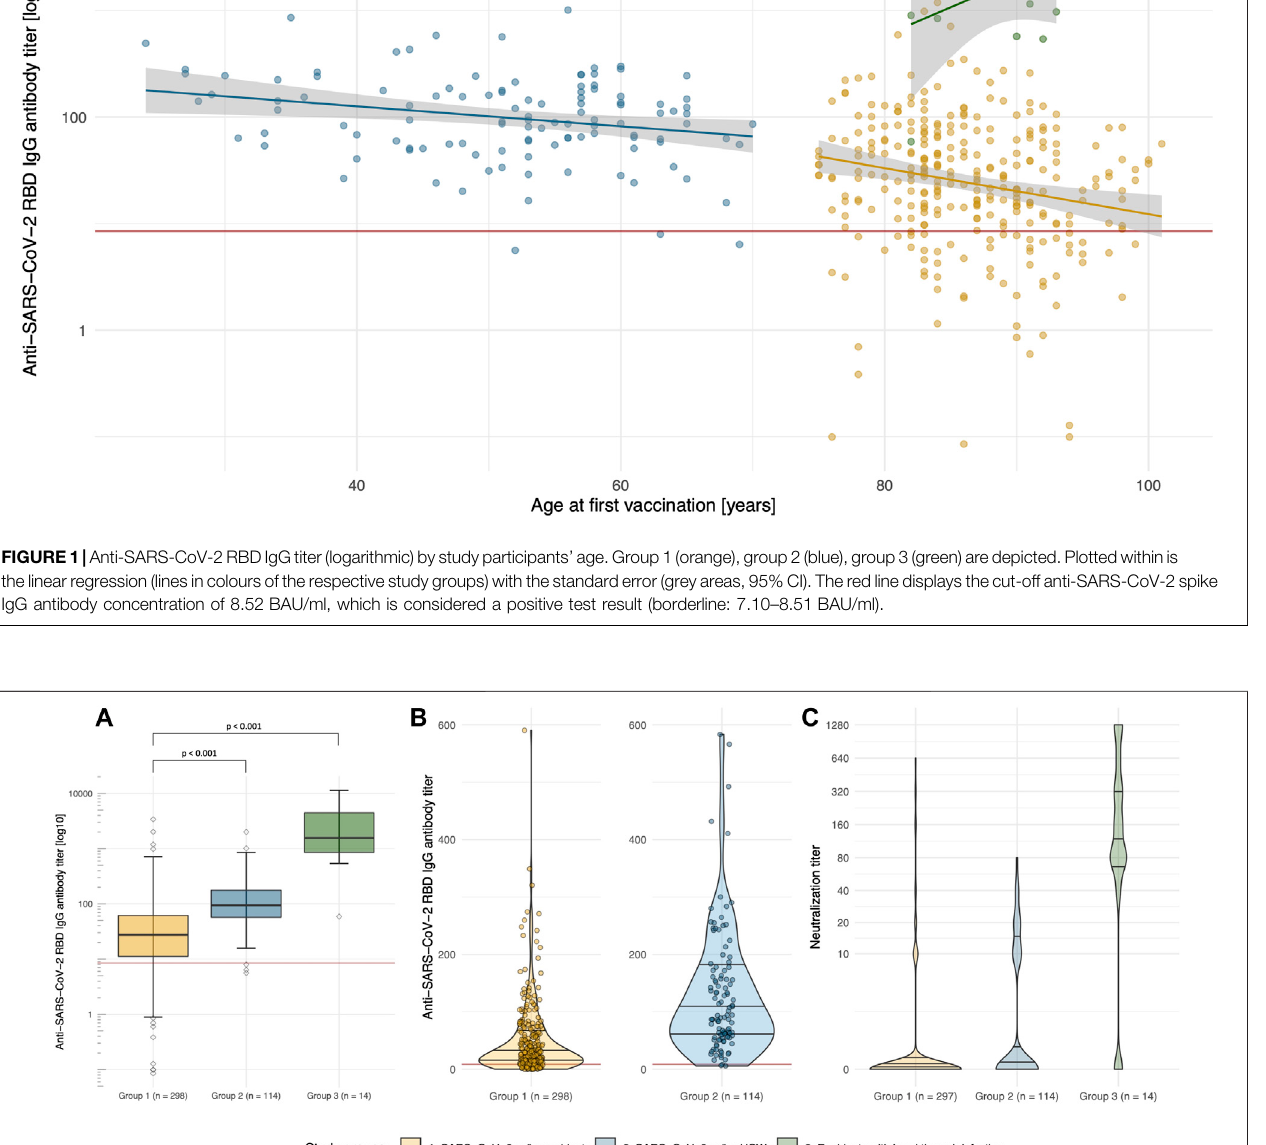
Frontiers in Aging |